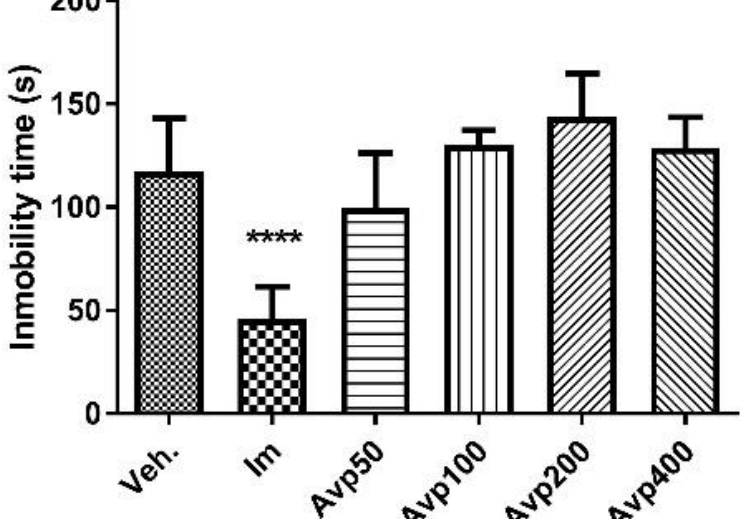
Figure 5. Immobility time (s) in the tail suspension test for the groups ( n = 6) treated orally with three doses in a 24-h period of Aloysia virgata var. platyphylla (Avp). Im.: imipramine. Veh: tween 80, 10%. The data correspond to the mean ± SD. One-way ANOVA and Dunnett’s post hoc test were performed. **** p < 0.0001.